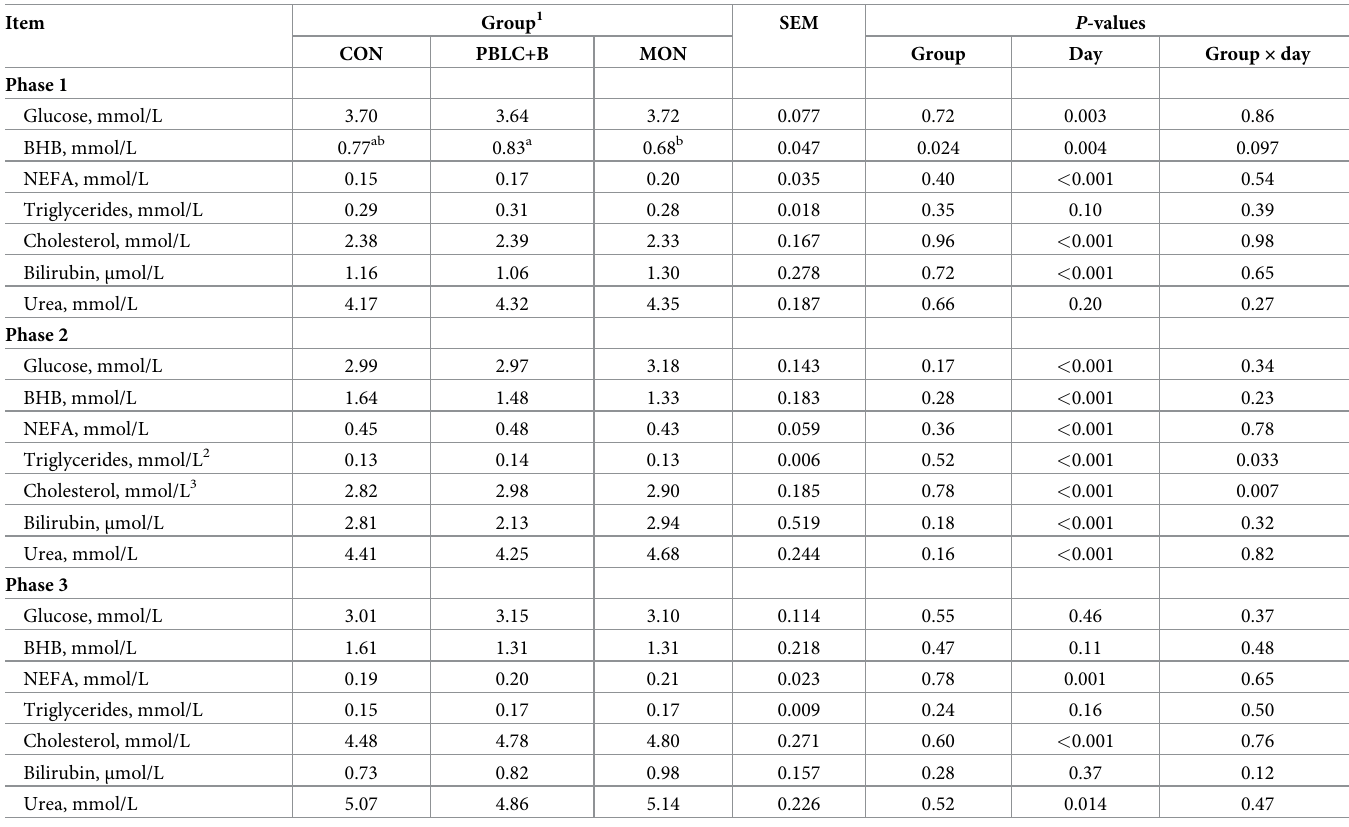
Table 5. Serum metabolite concentrations in cows receiving plant bioactive lipid compounds and biotin (PBLC+B; n = 18) from d -21 to 37 relative to parturition, cows receiving a monensin bolus (MON; n = 18) at d -21 or cows receiving no such supplements (CON; n = 17).